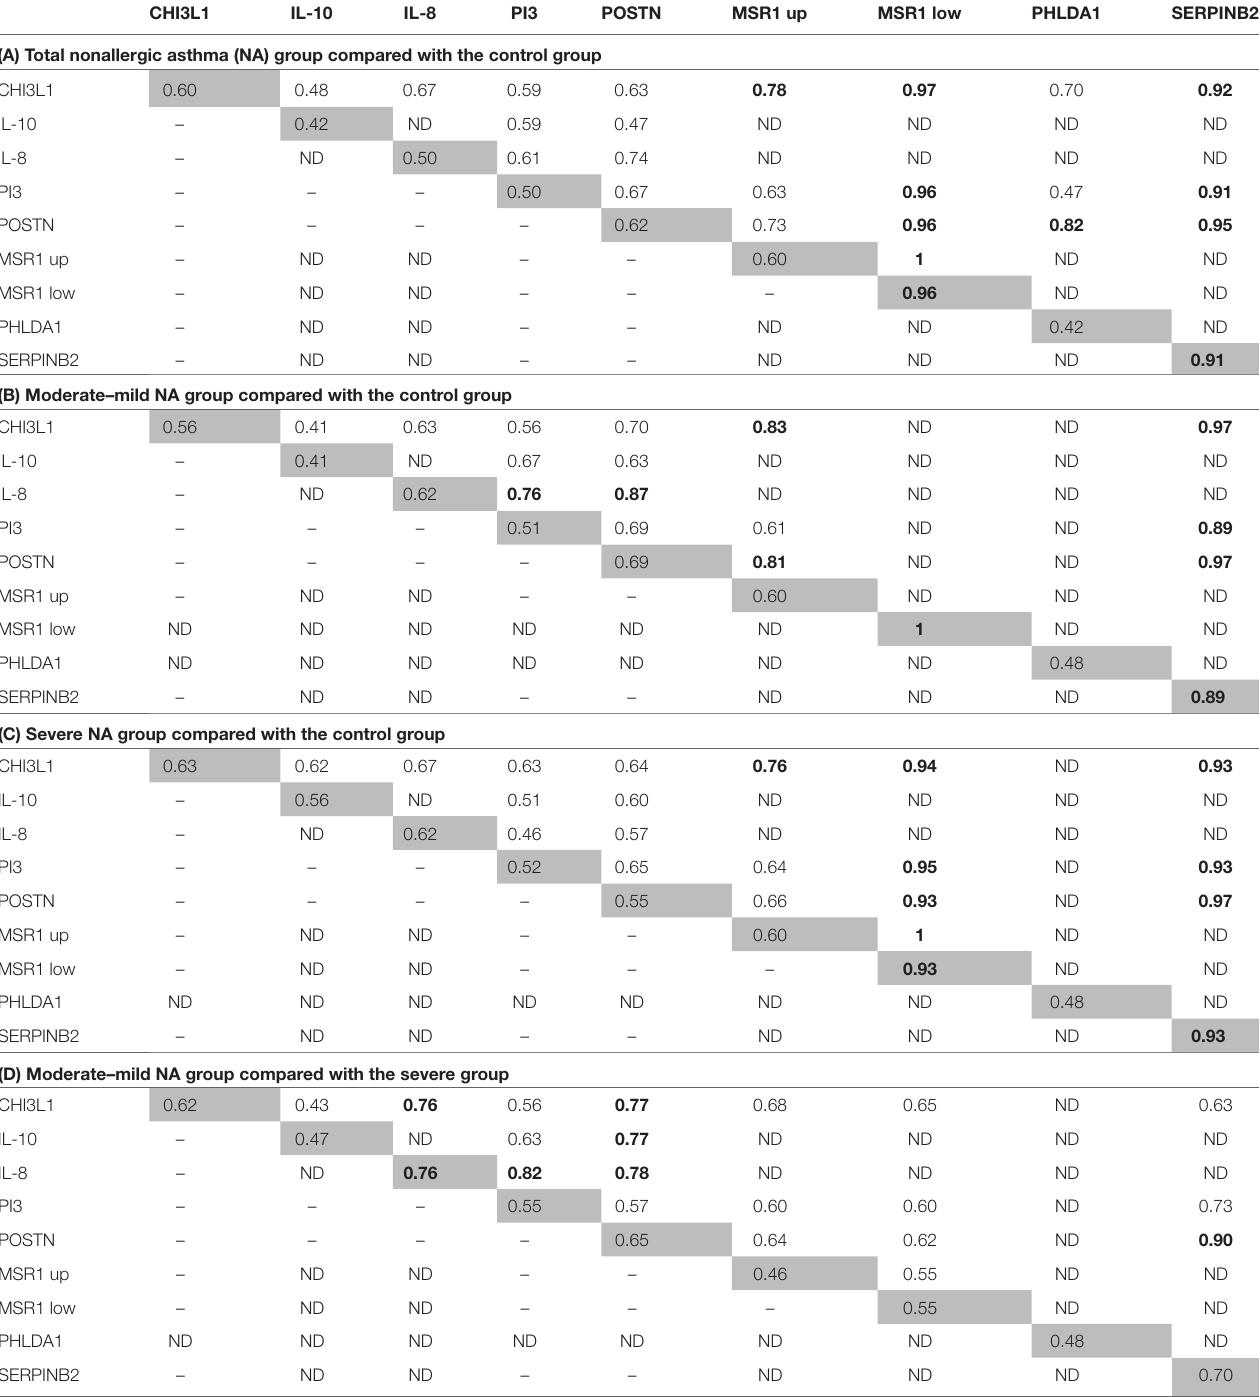
TaBle 3 | Receiver operating characteristic (ROC) curve analyses of the protein expression combining two